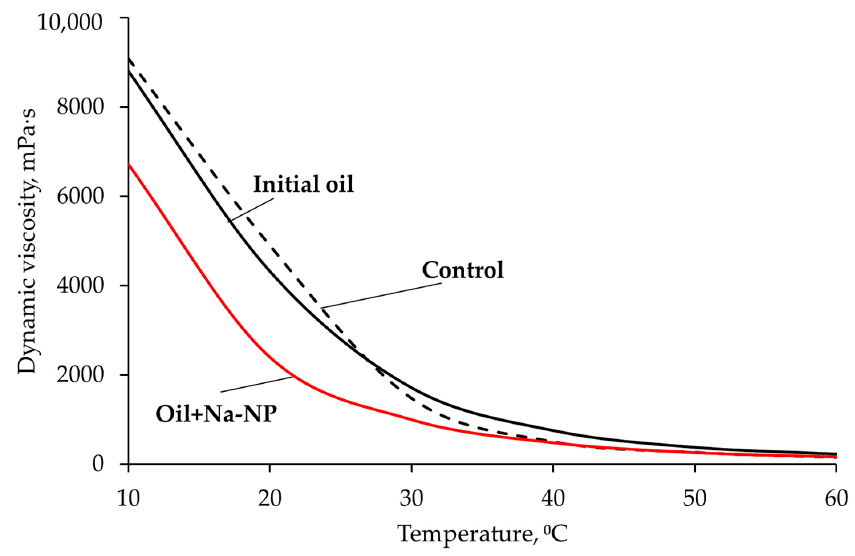
Figure 10. Temperature-dependent dynamic viscosity of oil samples.